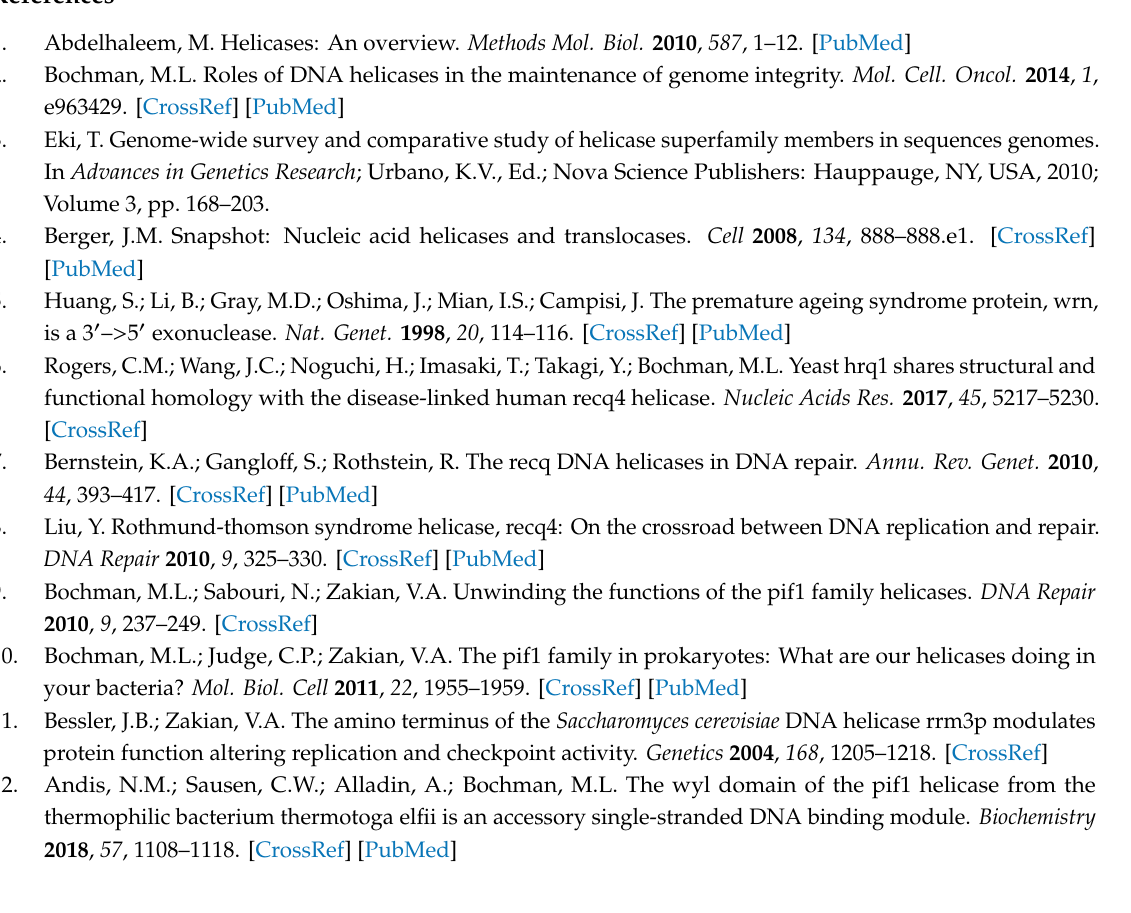
Figure S1: Pif1 and Pif1 ∆ N are overexpressed to similar levels in vivo, Figure S2. Pif1 ∆ N binds ssDNA tightly and unwinds DNA with similar kinetics to full-length